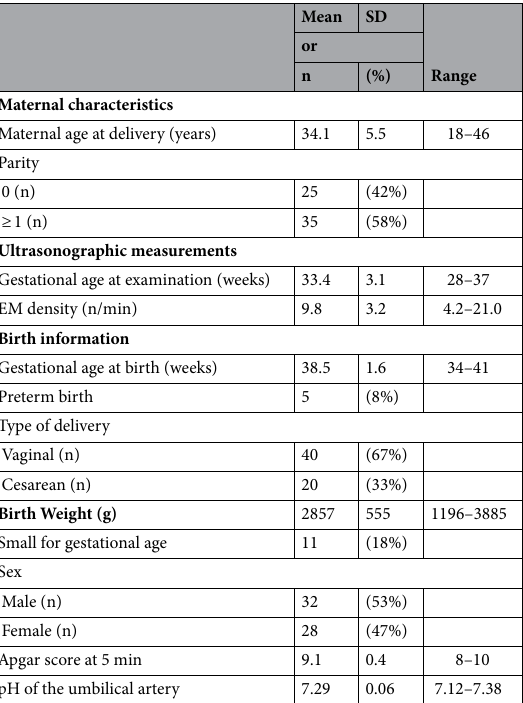
Table 1. Baseline characteristics and outcomes of the study population (60 cases). SD, standard deviations; EM, eye movement; CBCL, Child Behavior Checklist. *The items using for analysis and outcome were written in bold font.